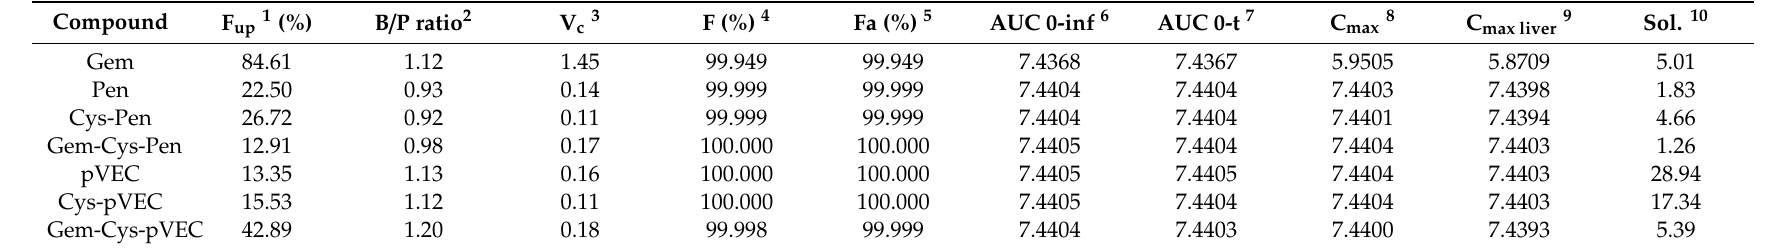
Table 6. Predicted pharmacokinetic properties of studied molecules determined with GastroPlus ™